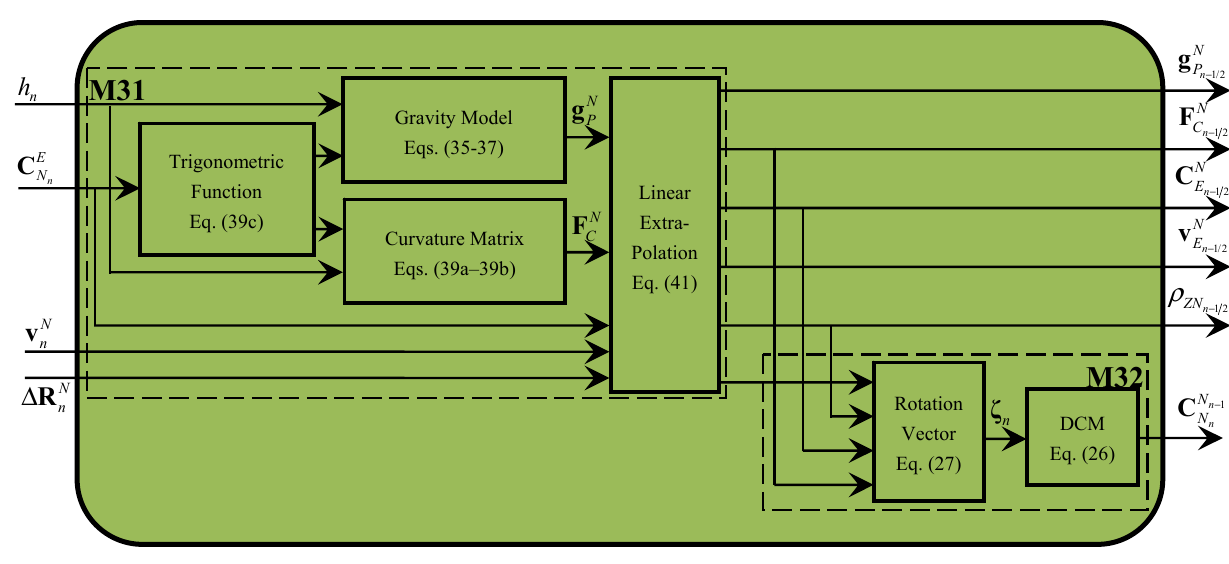
Figure 5. Diagram of module